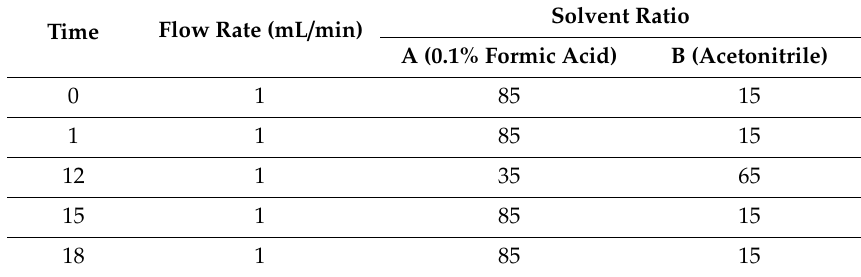
Table 8. Gradient elution system for high-performance liquid chromatography (HPLC) analysis.